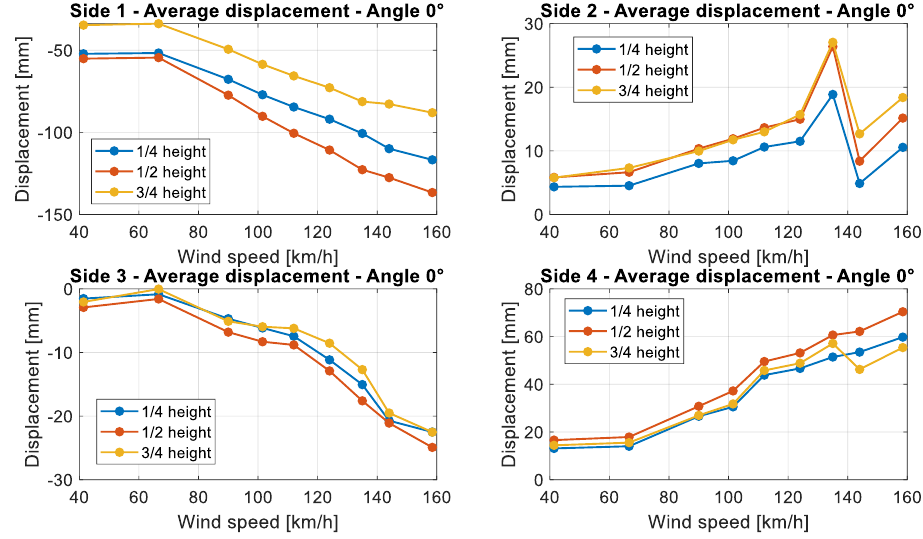
Figure 14. Comparison between average displacements at different heights of sections for the squared structure at 0° angle, for each side of the structure going from side 1 to 4.